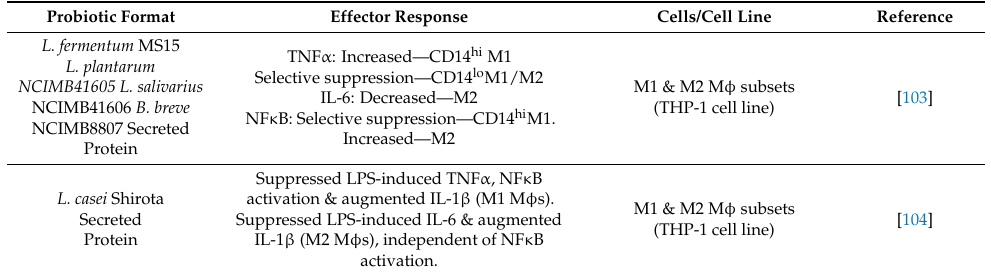
Probiotic-derived MAMPs, secreted products and metabolites modulate immune signaling